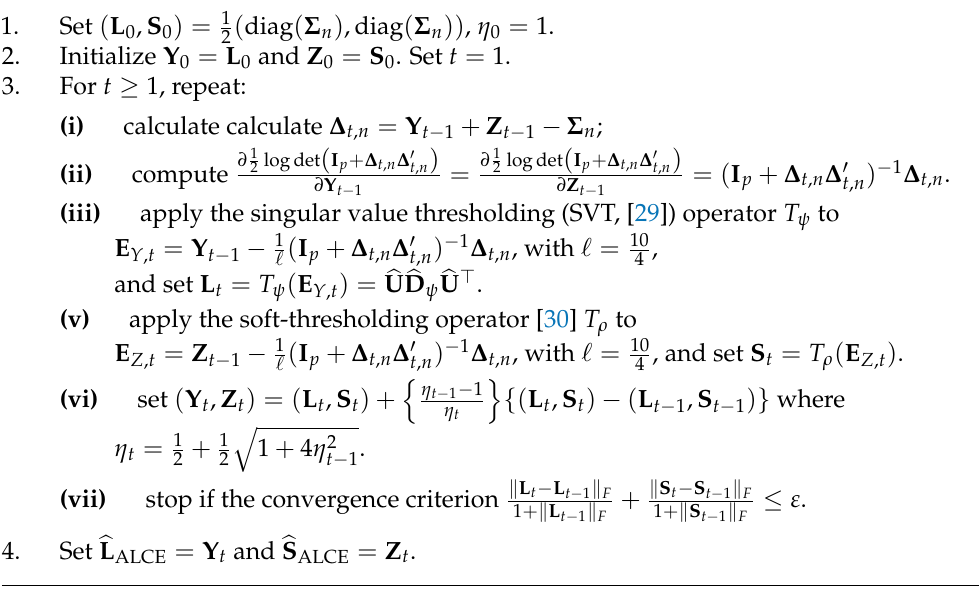
Algorithm 1 Pseudocode to solve problem (33) given any input covariance matrix Σ n